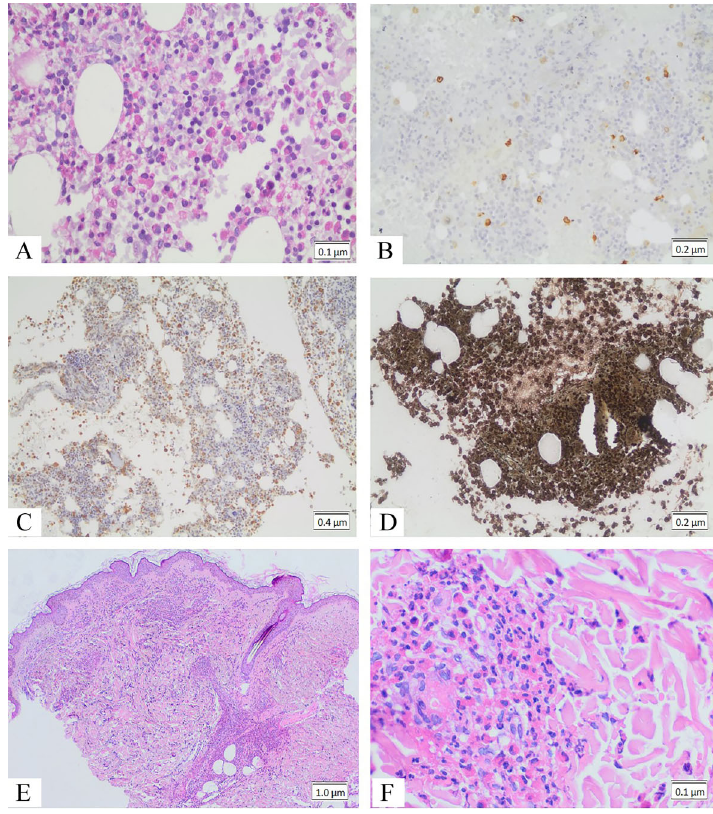
Figure 2. A , Bone marrow biopsy (HE 400 (cid:1) , scale bar 0.1 m m) with an enrichment of eosinophils. B , Bone marrow biopsy (200 (cid:1) , scale bar 0.2 m m) with CD117 immunostaining, suggesting an increase of mast cells. The immunostaining for myeloperoxidase ( C , 100 (cid:1) ,